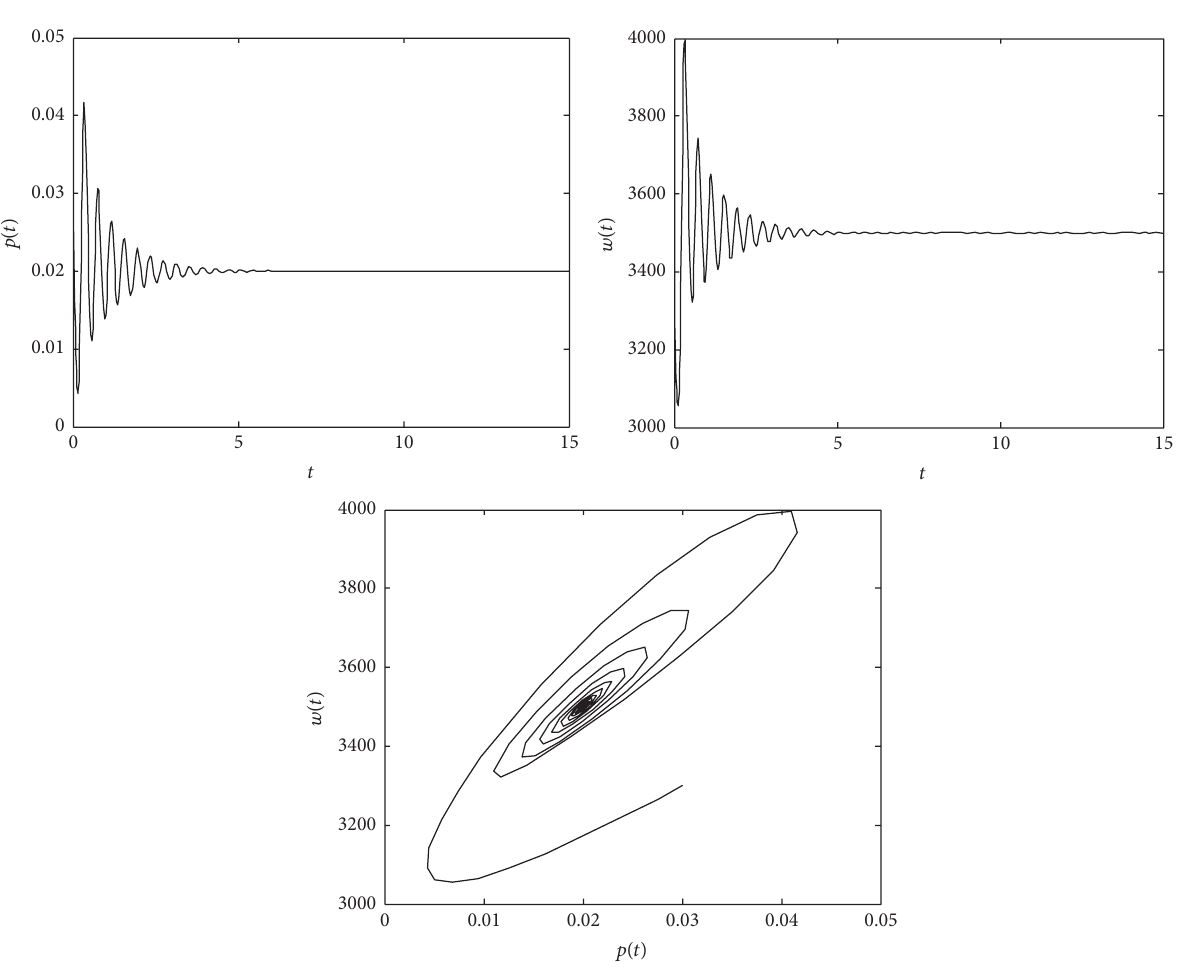
Figure 5: State plot and phase plot of hybrid controlled system (5) with 𝛼 = 1000 and 𝑘 = 0.8